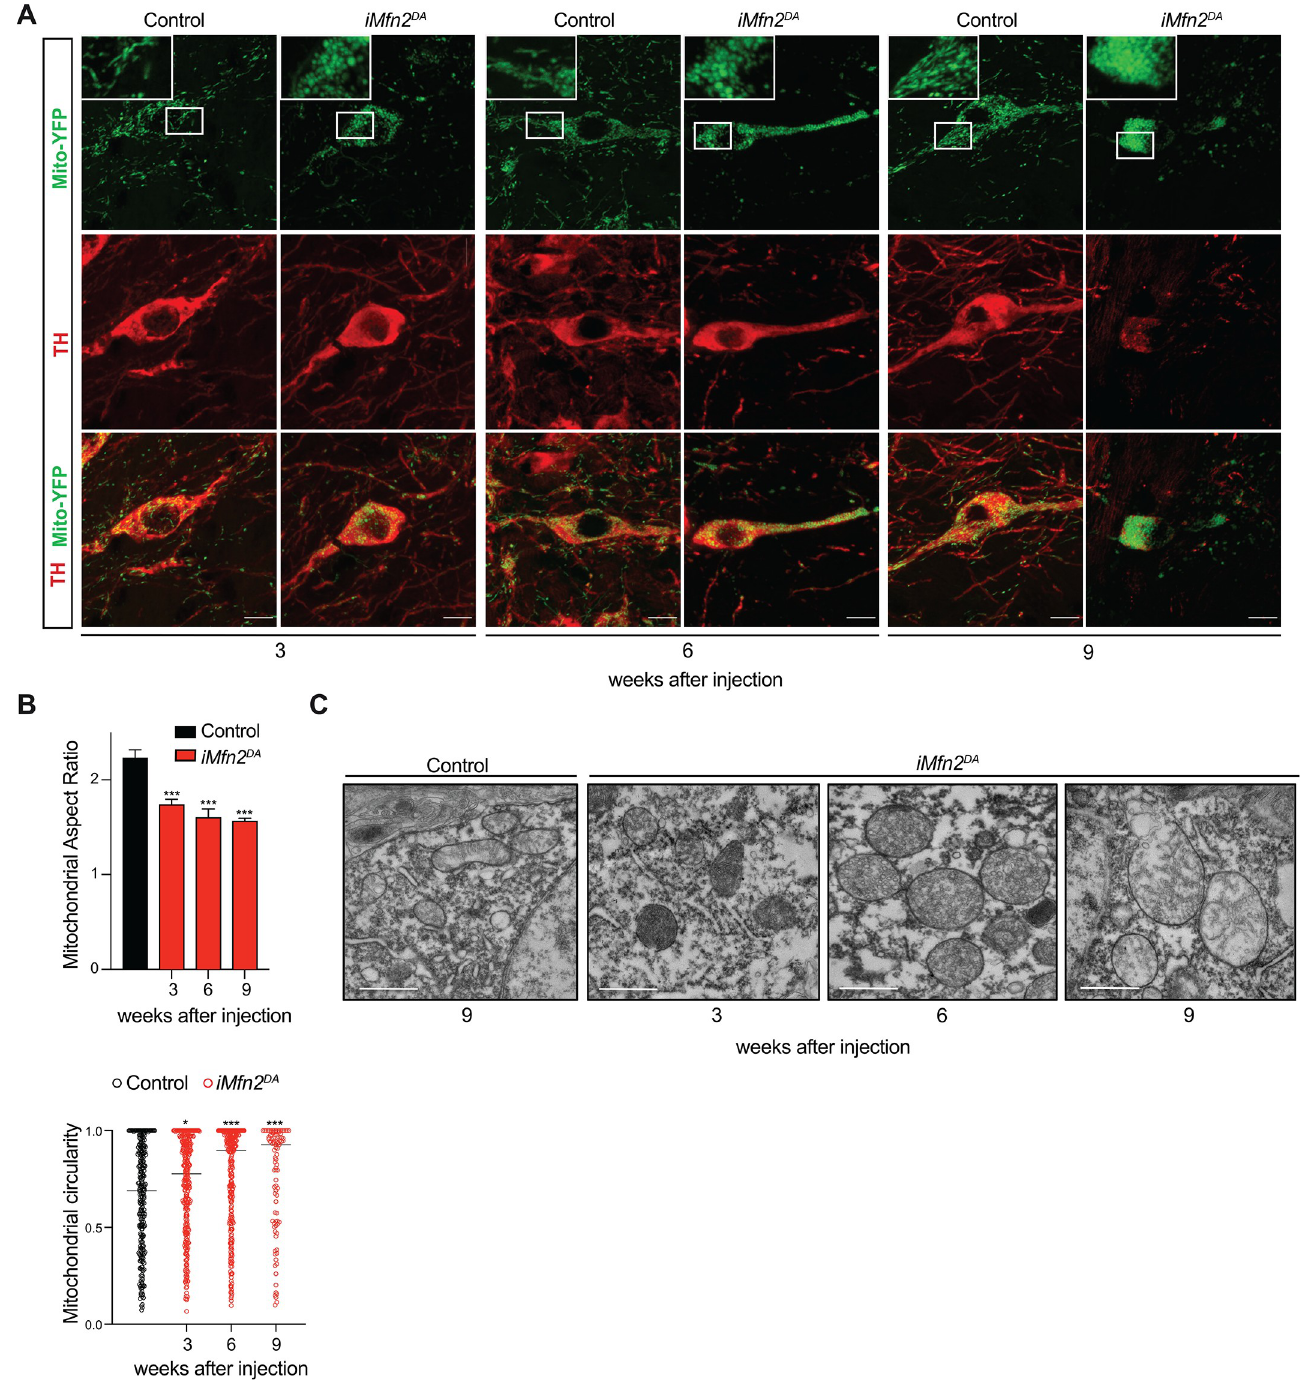
Fig 2. Loss of Mfn2 in adult DA neurons affects mitochondrial morphology and cristae structure. Analyses were performed 3, 6, and 9 weeks after tamoxifen injection in control and iMfn2 DA mice. (A) Representative confocal microscopy images of YFP-labelled mitochondria (green) in TH immunoreactive neurons (red) (Scale bars: 10 μ m). (B) Quantification of aspect ratio and mitochondrial circularity from confocal images in TH+ DA neurons. AR data are shown as mean ± SD and circularity data as median of individual mitochondria. ��� p < 0.00, n = 3 for each genotype. (C) Representative electron microscopy images of mitochondrial cristae structure (Scale bars: 1 μ m).